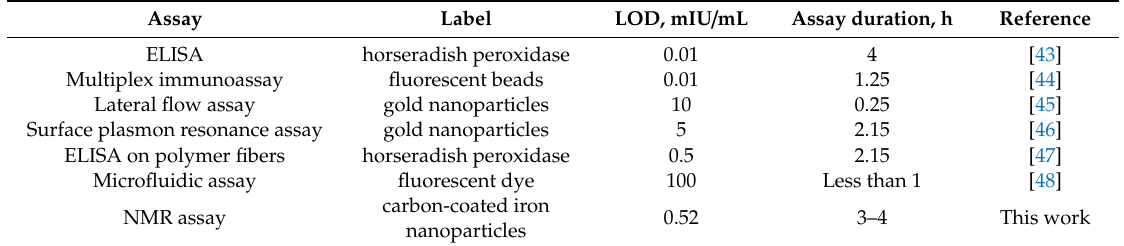
Table 2. Comparison of the NMR-assay with anti-TT IgG detection methods described in